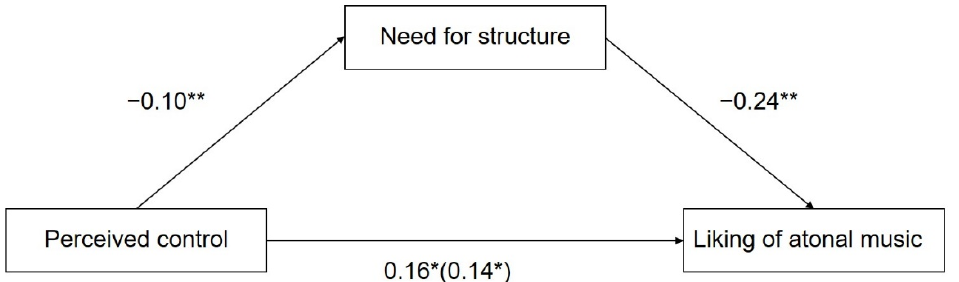
Figure 1. Mediation model of the need for structure in the relationship between perceived control and liking of atonal music. Path values are the path coefficients with standard errors. * p < 0.05. ** p < 0.01. Table 2. Mediating effect test of the need for structure.